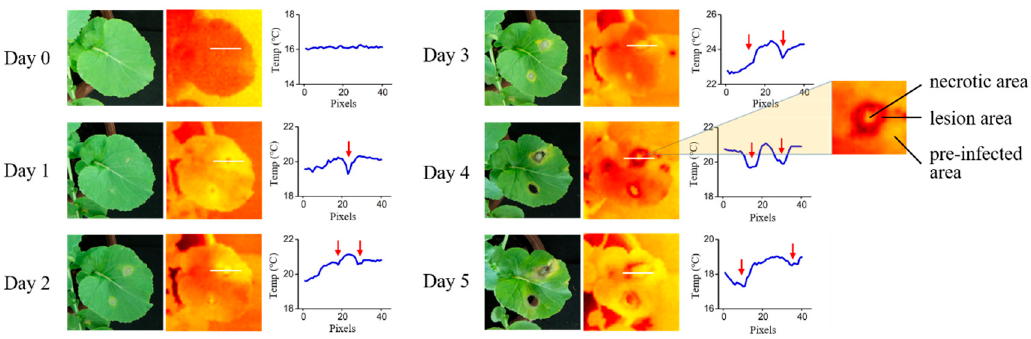
Figure 6. The temperature change curves through the lesion area before and after infection. Three areas (necrotic, lesion and pre-infected areas) gradually appeared in the disease spot.